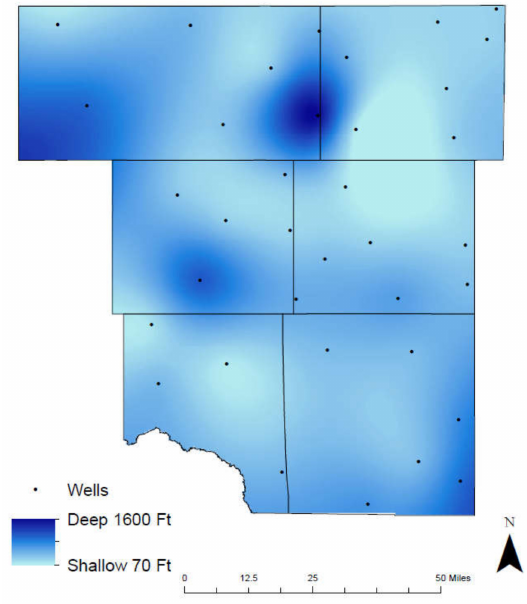
Figure 2. Groundwater well depth in the study